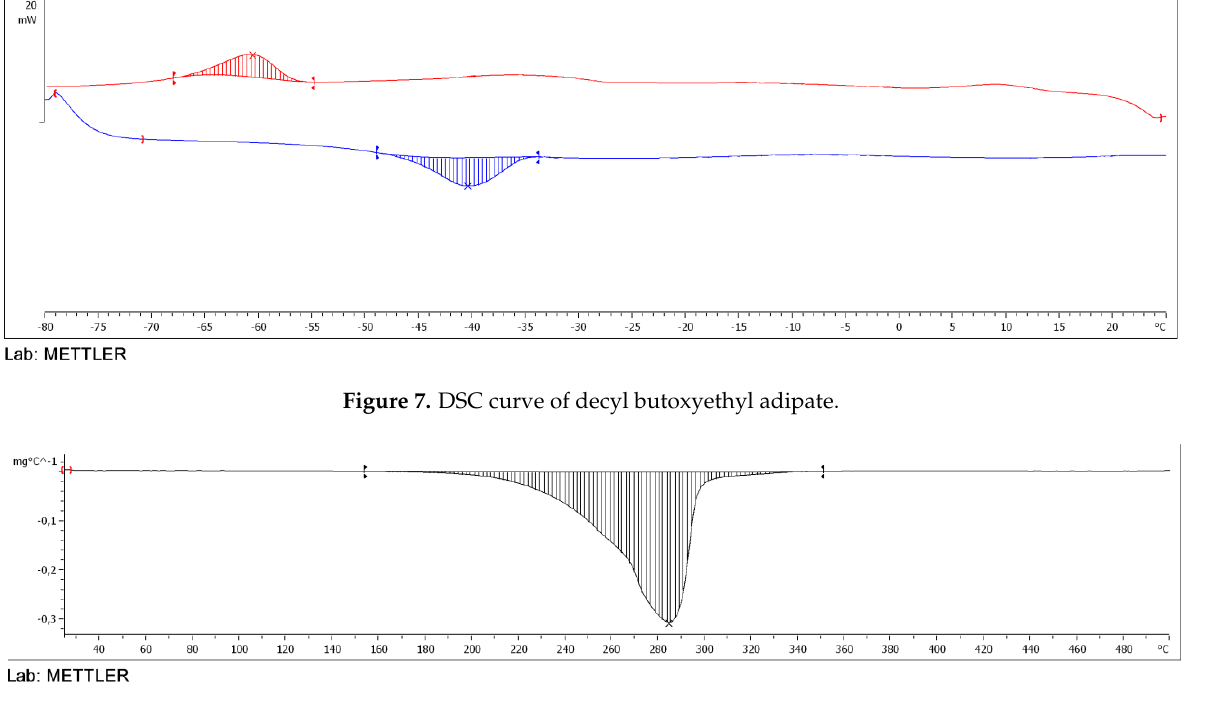
Figure 8. DSC curve of DOP.